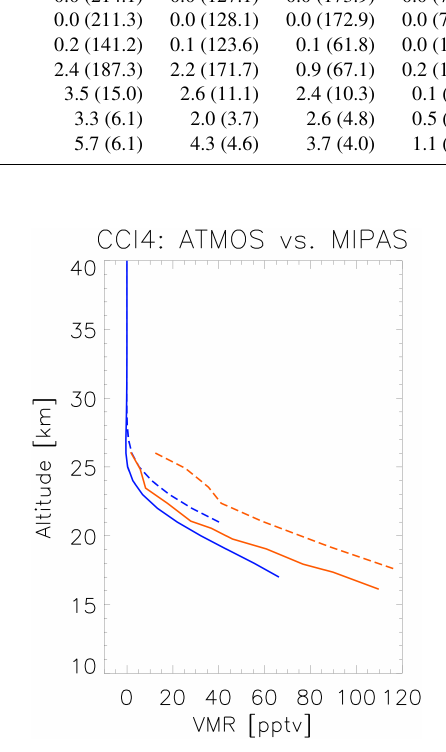
Figure 12. Qualitative comparison of profiles from ATMOS (or- ange) taken during the ATLAS-3 mission (as shown in Zander et al., 1996, Fig. 1) and climatological means of MIPAS (blue) during 3– 12 November of each year. Solid lines refer to midlatitude measure- ments (35–49 ◦ N). Dashed lines indicate subtropical measurements (20–35 ◦